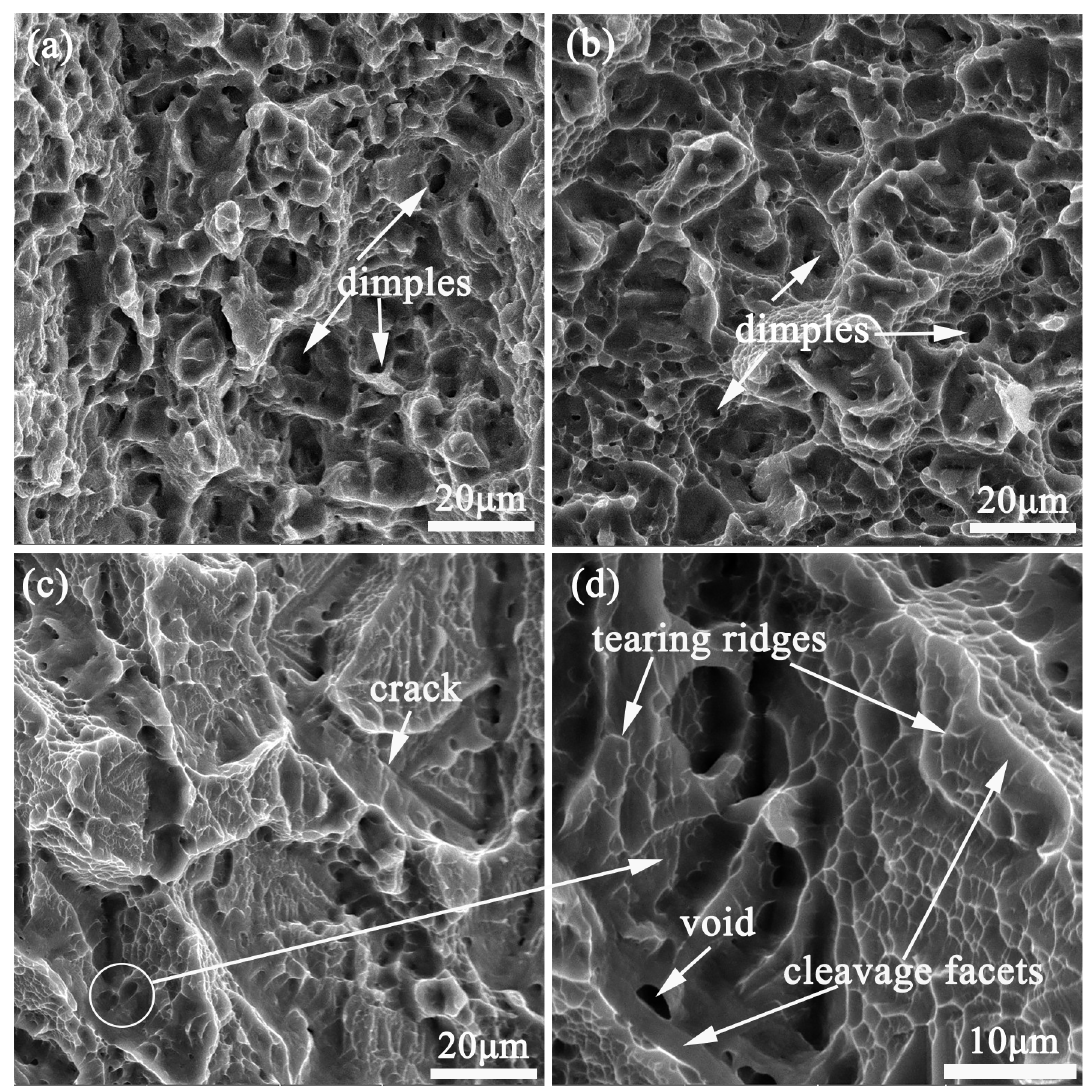
Figure 5. SEM images of tensile fracture surface of the Ti-6Al-4V alloys with different heat treatment temperature tested at room temperature: (a) 850ºC/1h+WQ; (b) 900ºC/1h+WQ; (c) 950ºC/1h+WQ; (d) zoom in of image